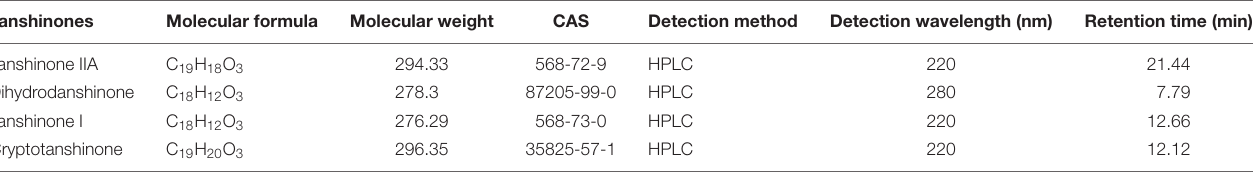
FIGURE 1 | The chemical structure of four tanshinone monomers. TABLE 1 | Basic physicochemical properties of tanshinone